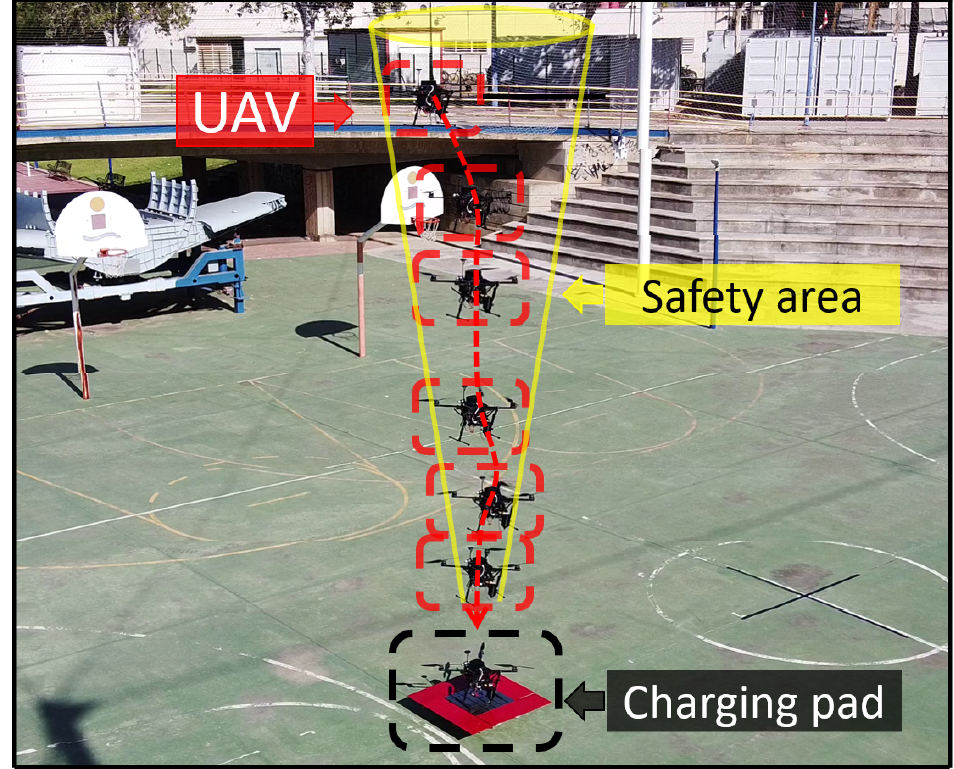
Figure 16. Trajectory followed by the UAV during landing—example of the cone made for a safer de-